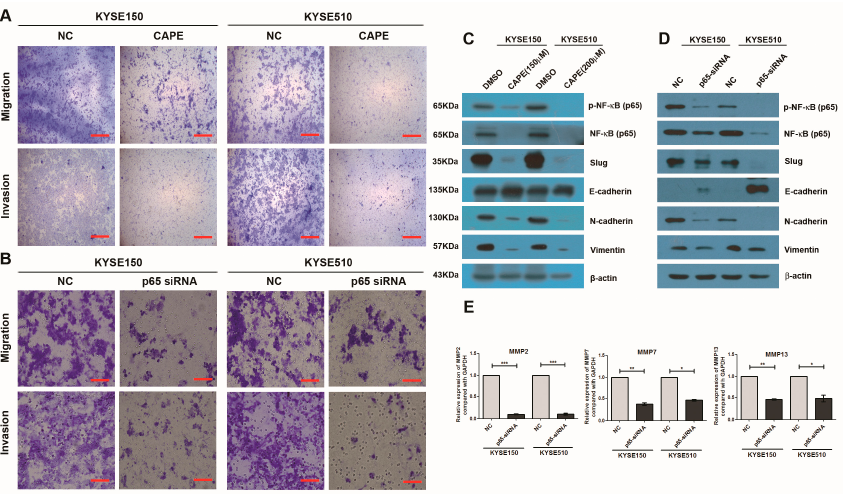
Figure 6. Inhibition of NF- κ B signaling pathway or knockdown of NF- κ B ( p65 ) phenocopied the effects of miR-145-5p on the migration, invasion and EMT of ESCC cells. ( A ) Cell migration and invasion were detected using Transwell assay under caffeic acid phenethyl ester (CAPE) treatment. Images of migration and invasion are presented ( n = 3), the bars represent 200 µm; ( B ) Cell migration and invasion were detected using Transwell assay after p65 small interfering RNA (siRNA) transfection. Images of migration and invasion are presented ( n = 3), the bars represent 200 µm; ( C , D ) Western blotting assay examined the levels of NF- κ B (p65), p-NF- κ B ( p65 ), Slug, E-cadherin, N-cadherin and vimentin ( n = 3); ( E ) The mRNA expressions of MMP2 , MMP7 and MMP13 were determined by real-time PCR ( n = 3). NC: non-specific negative control. Three independent experiments were performed. * p < 0.05; ** p < 0.01; *** p < 0.001.